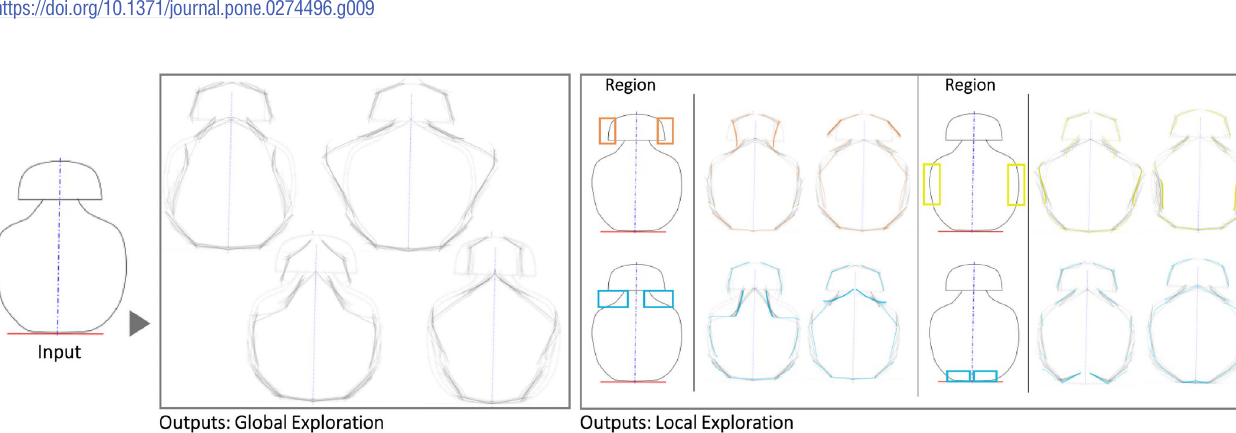
Fig 9. Some of the Global and Local shape variations generated with Shapi for the conceptual exploration of a soap dispenser. The Seed is based on an exploration by product designer & illustrator Von der Heyde [88].